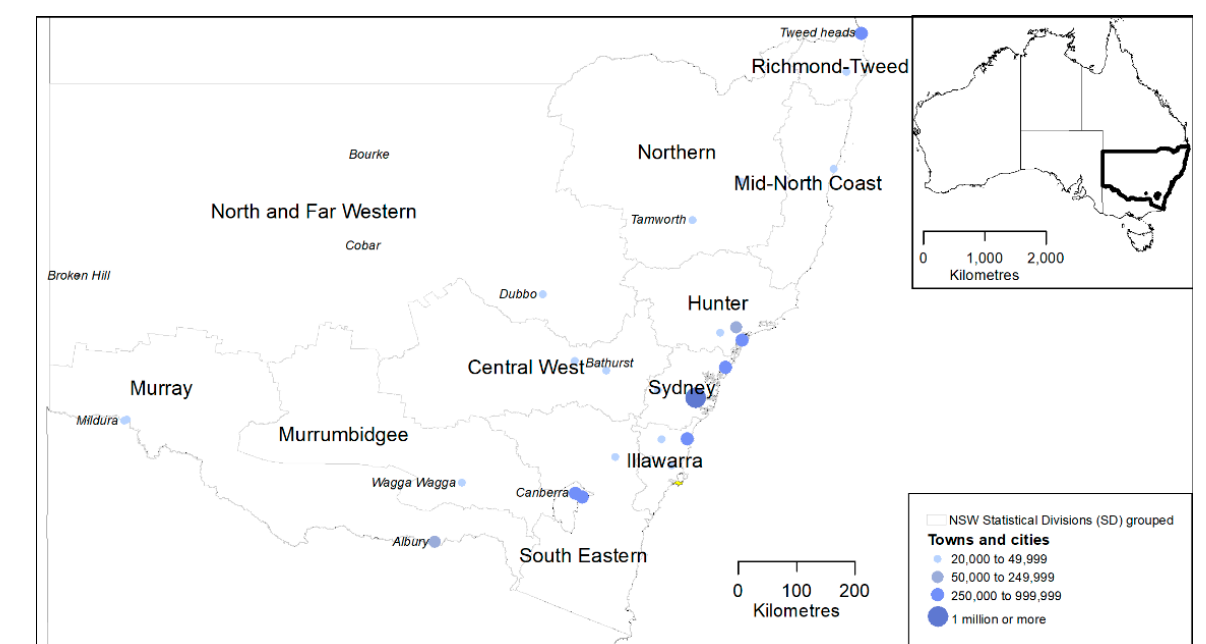
Figure 1. Statistical divisions (SDs) of NSW from the 2006 edition of the Australian census geography; the small populations of North West and Far Western SDs were combined to support statistical models. Population centres and selected rural farming communities are also shown for context.